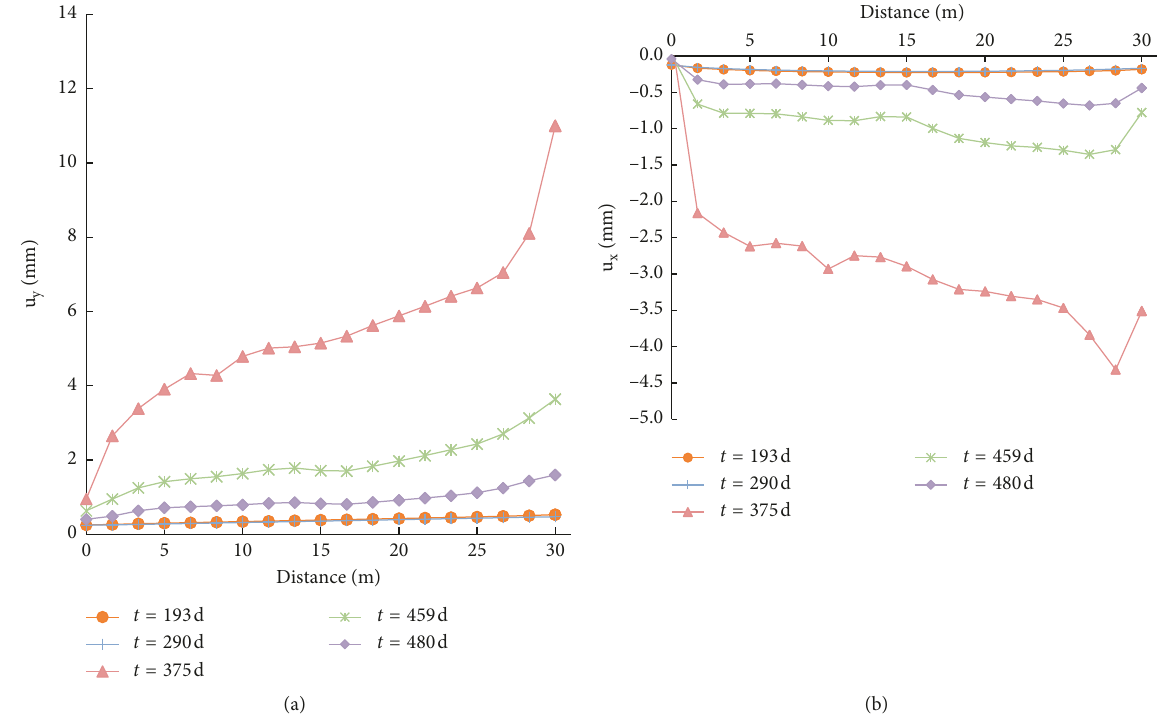
Figure 11: Distribution of the slope surface displacement. (a) Vertical displacement; (b) horizontal